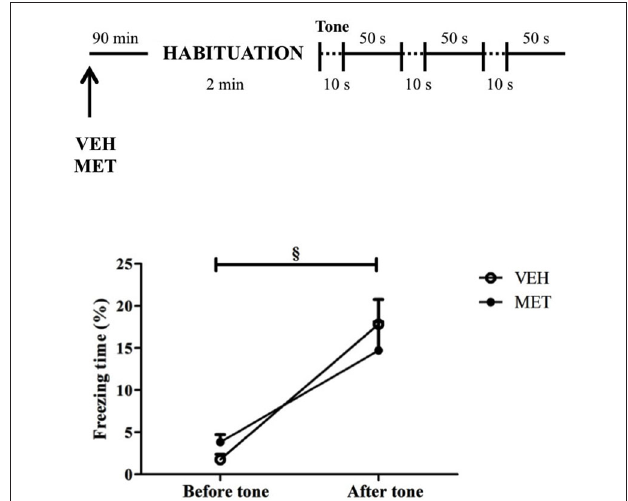
FIGURE 8 | Acute metyrapone treatment did not impair animal’s ability to express fear . Metyrapone treatment did not reduce freezing after three unknown and potentially threatening tone presentations. VEH = vehicle group ( n = 10); MET = metyrapone group ( n = 10). § P < 0.05, comparing pre and post-tone.